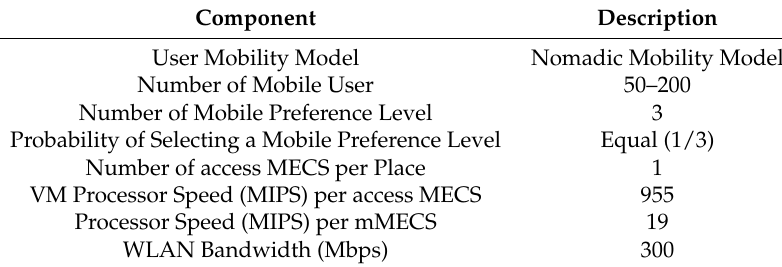
Table 2. Simulation